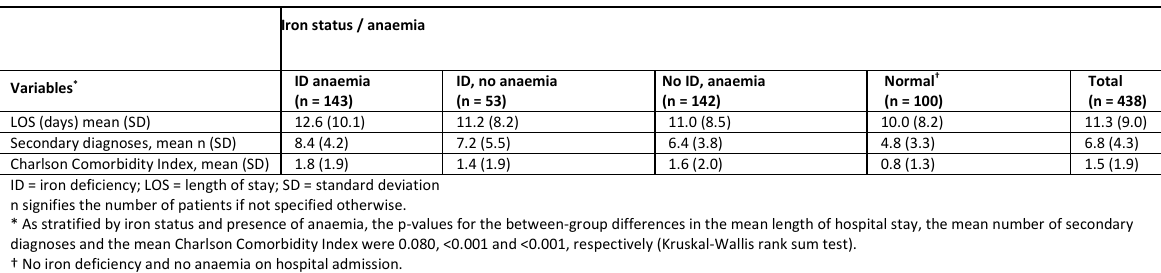
Table 5: Length of hospital stay, number of secondary diagnoses and Charlson Comorbidity Index stratified by iron status and presence of anaemia on hospital admission (number of patients = 438). Iron status / anaemia